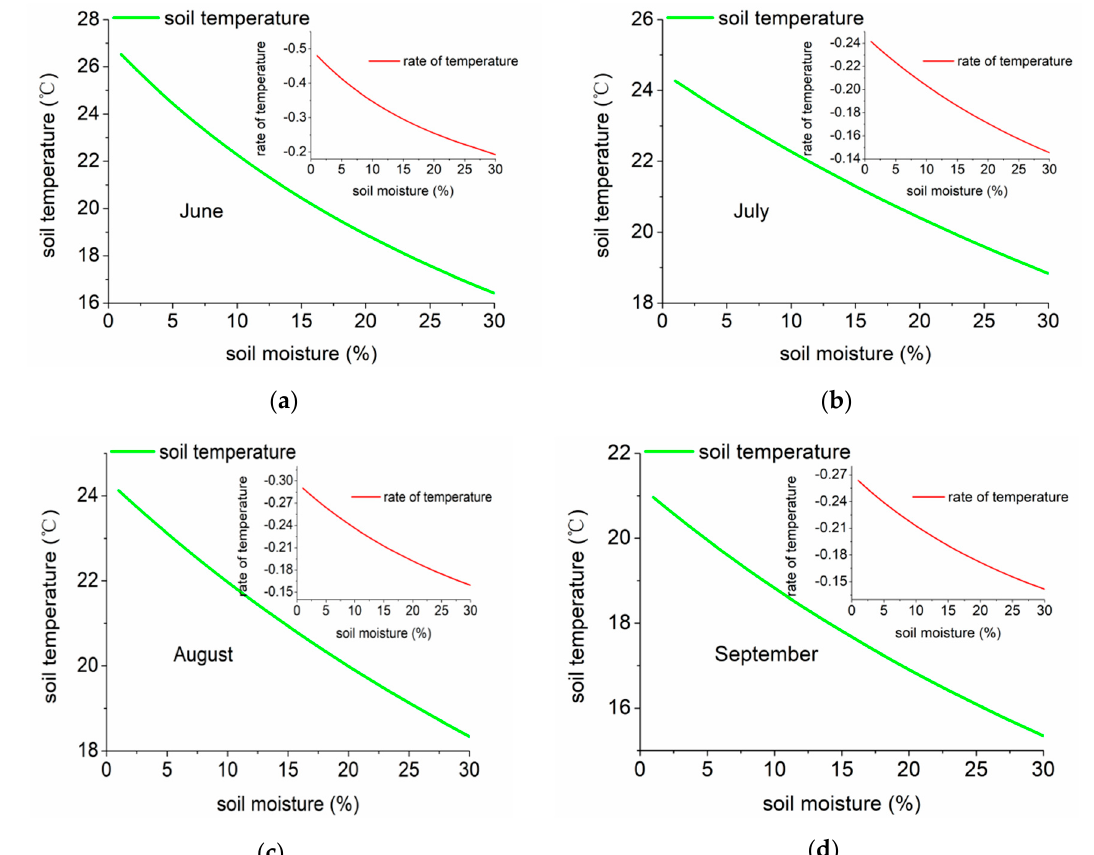
Figure 8. Relationship between soil moisture (W) and temperature (T) and the rates of soil temperature change with soil moisture at different periods. ( a ), ( b ), ( c ) and ( d ) represent June, July, August and September, respectively.